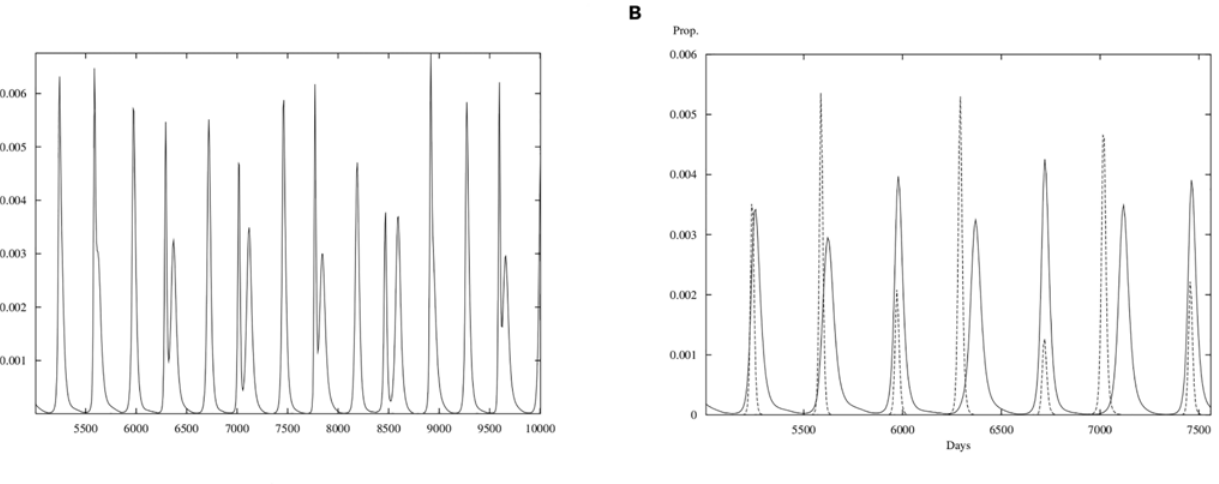
Fig 8. Simulations for the mathematical model. (A) Total cases (RSV plus influenza). (B) RSV cases are plotted with a continuous line; influenza cases plotted with a dashed line. Horizontal axis is time in days; vertical axis is proportion of the population. Plot is shown after a transient time of 5000 days where b θ = 0.0001 for R R σ = 0.7, b 1 = 0.9162 and 2 = 0.4566 and 01 = 1.83 and 02 = 2.28.